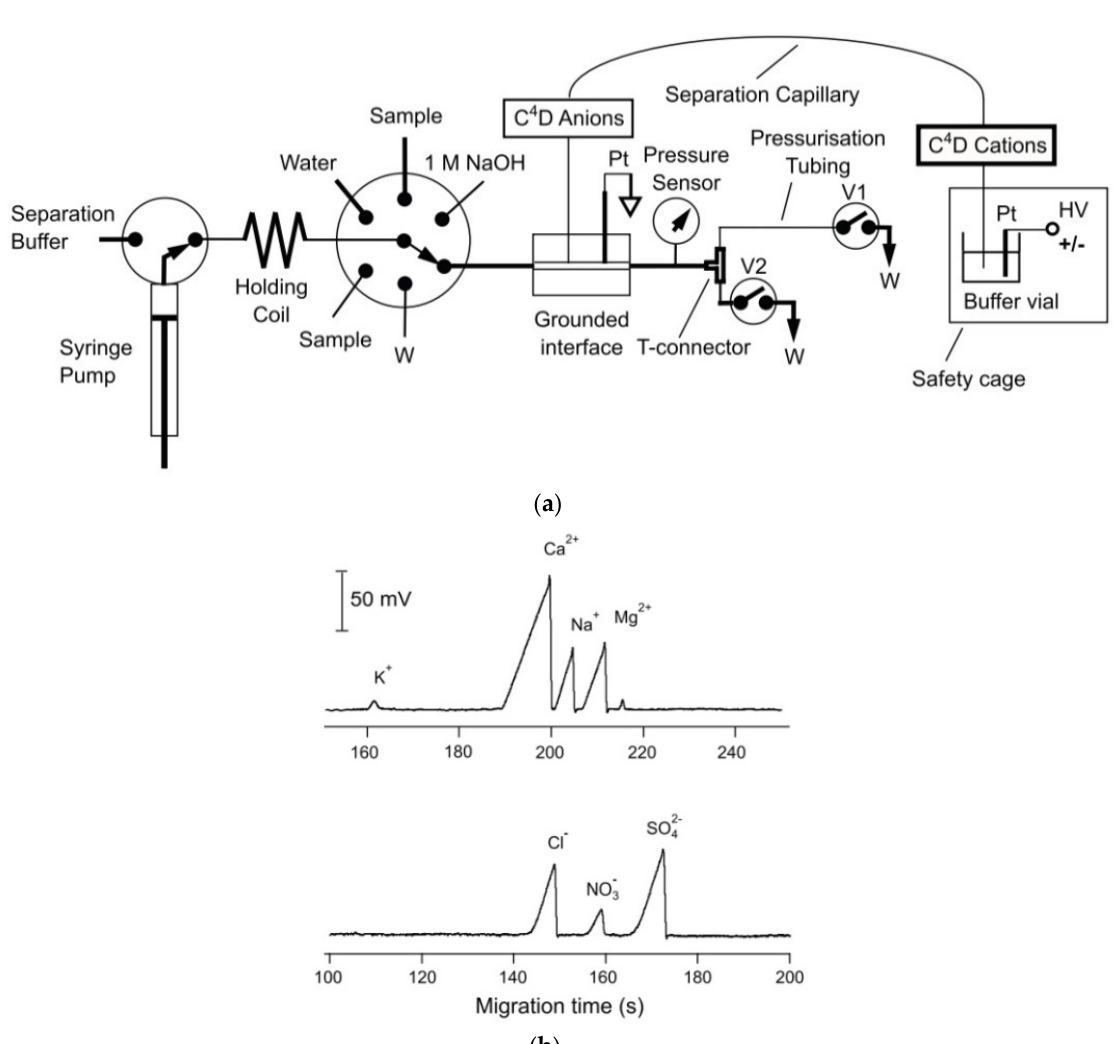
Figure 5. Schematic diagram of an SIA-CE system with dual contactless C 4 D detectors for simultaneous determination of anions and cations ( a ), and an example of its application in the analysis of tap water ( b ) [58]. In A: C 4 D: contactless conductivity detector; HV: high-voltage power supply; W: waste; and V1, V2: stop valves. In B: tap water of pH 4 was filtered and diluted 5 times before injections. Both sample plugs were injected at the grounded end of the capillary, with the plug of the anion sample delivered to the HV-end of the capillary with a pressure of 4.5 bar within 90 s. CE conditions: capillary—50 cm, 10 μ m I.D. ( L eff for cations—43 cm and L eff for anions—35 cm), BGE—12 mM His, 2 mM 18-crown-6, pH 4, E = 400 V/cm. (Reproduced under permission from Elsevier. License Number 5173120143146).